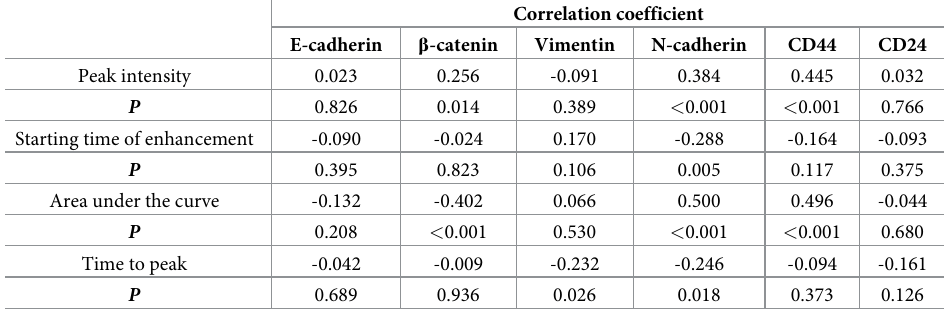
Table 5. Correlation analysis of CEUS parameters of breast cancer with relative mRNA expressions of CSC- and EMT-related